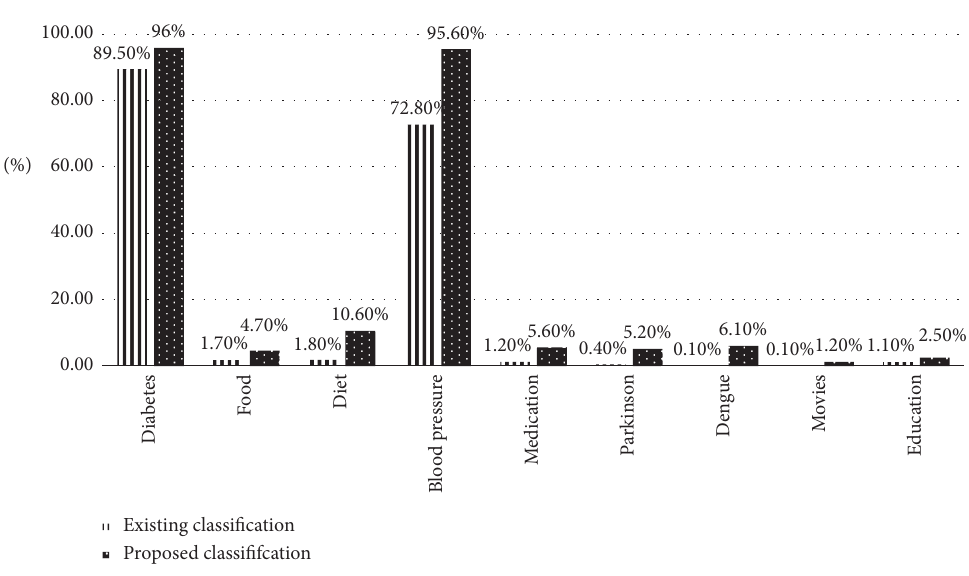
Figure 6: Performance comparison with existing